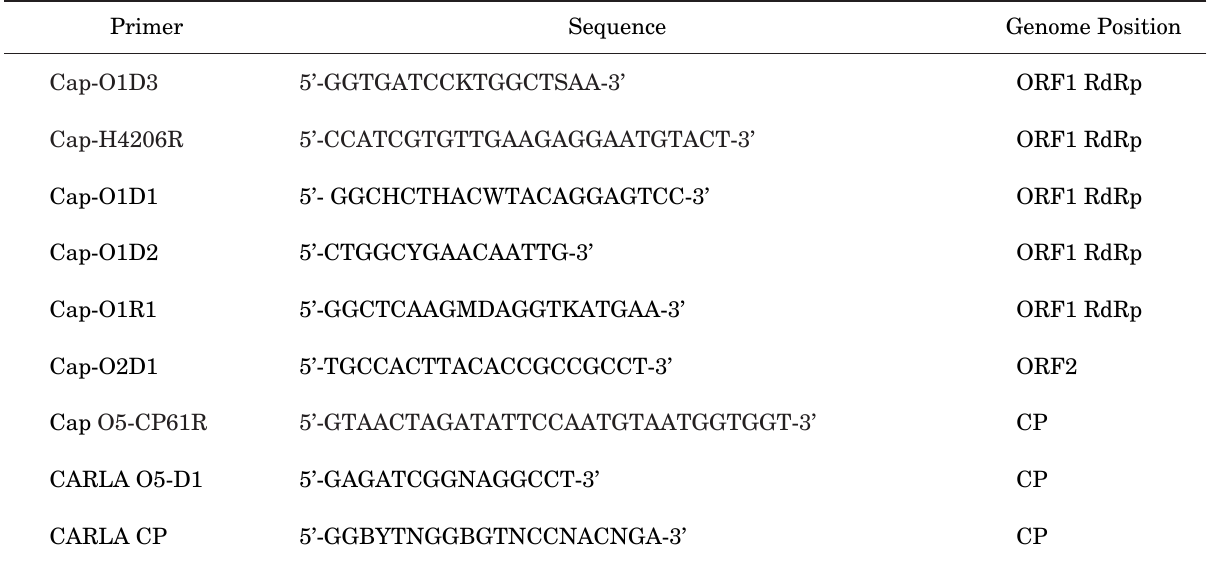
Table 1. Sequences and genome positions of primers used for caper carlavirus amplification by RT-PCR. Primer